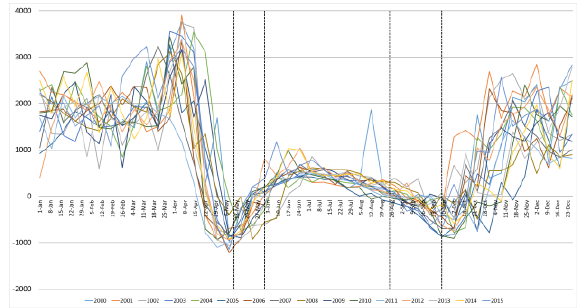
Figure 1. 2000-2015 graphs of NDWI values averaged for shrub vegetation cover in the 10 km window centered on the Syktyvkar meteorological station. Vertical lines are the average frames of the growing seasons computed using the ground observation data of the Syktyvkar meteorological